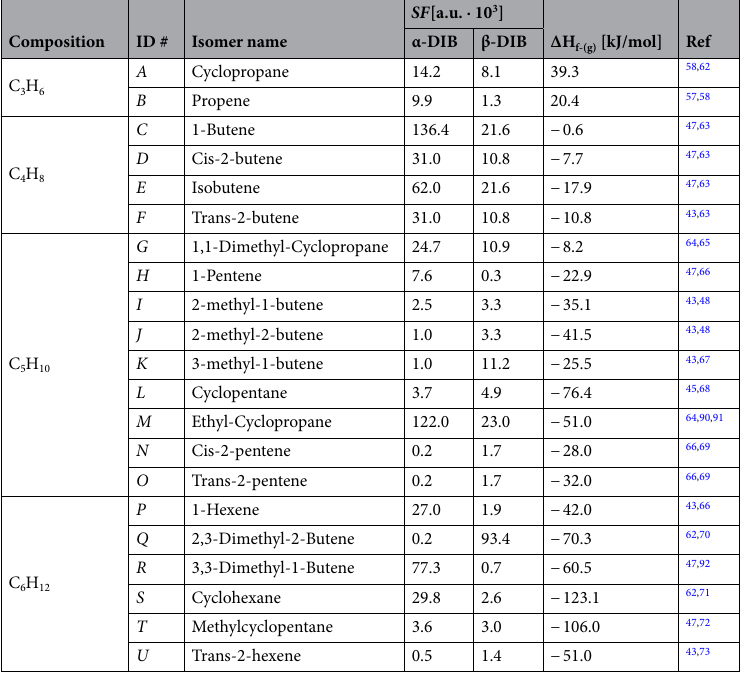
Table 3. Non-oxygenated intermediates identified in DIB reactions, respective scaling factors, and gas-phase heat of formation